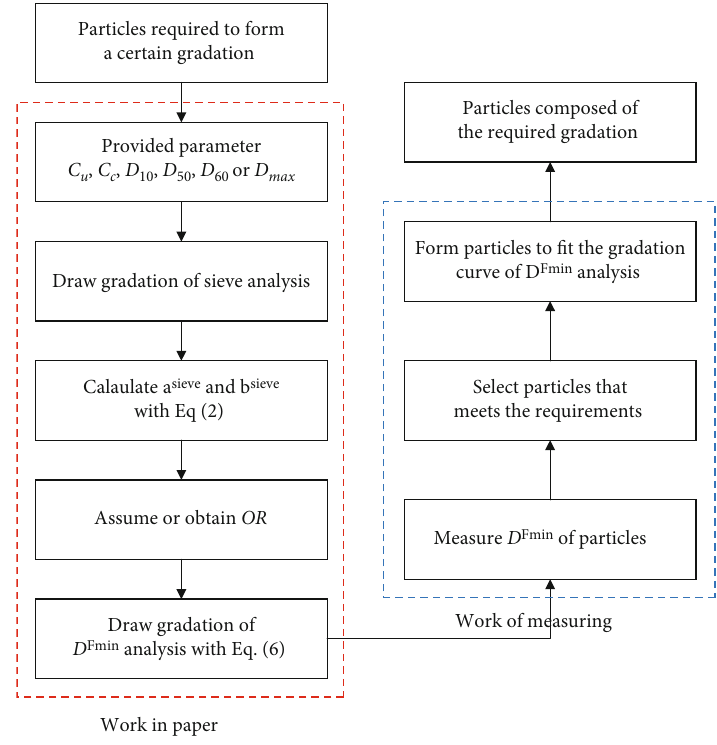
Figure 10: Process of obtaining gradations considering the e ff ect of the particle shape.